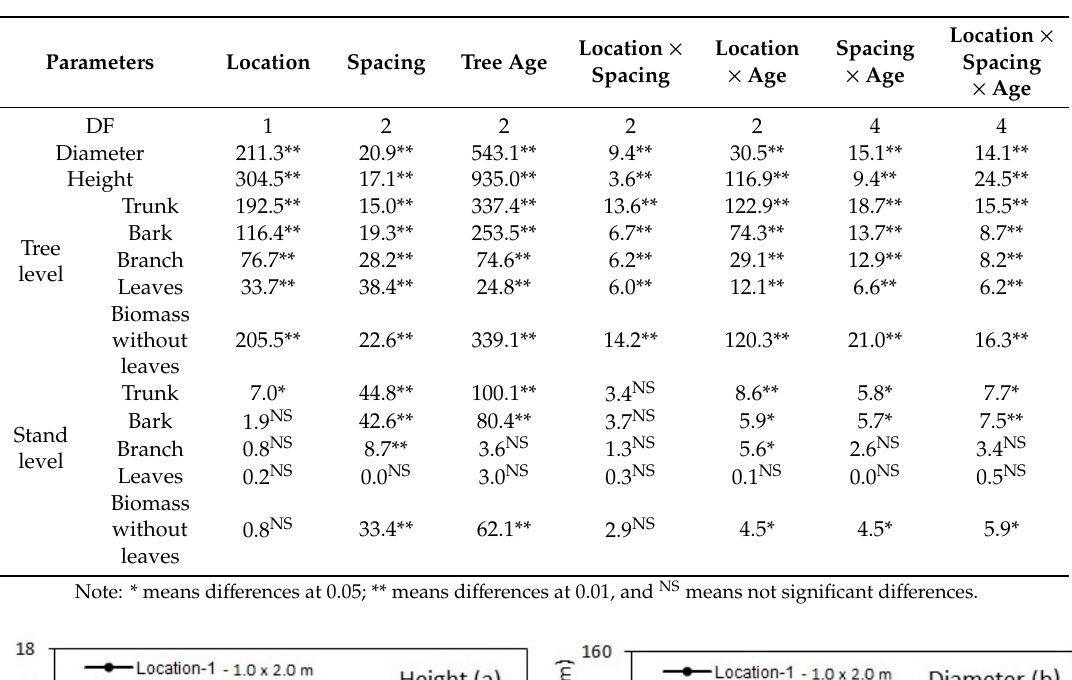
Table 4. F-values from ANOVA for diameter, height and biomass in short rotation energy plantations of Gmelina arborea in two di ff erent locations of Costa Rica.